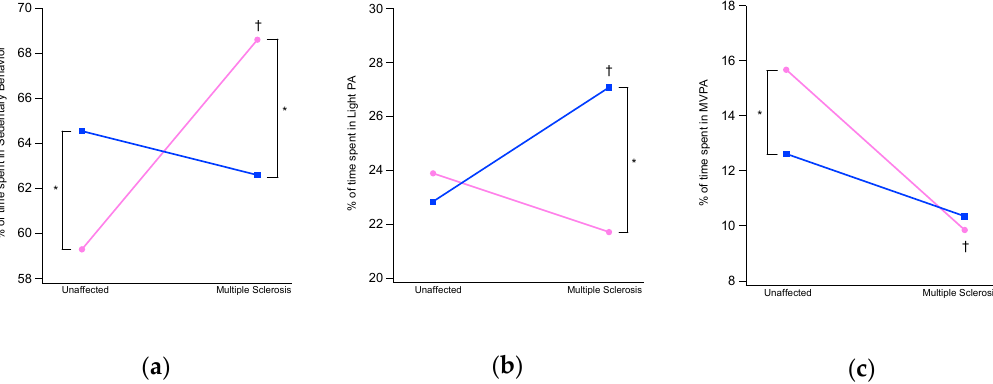
Figure 4. ( a ) percentages of time spent in Sedentary Behavior, ( b ) Light Intensity and ( c ) Moderate- to-vigorous intensity Physical Activity in women (pink lines) and men (blue lines) with Multiple Sclerosis and una ff ected individuals. The symbol † denotes a significant di ff erence between una ff ected individuals and people with MS after Bonferroni correction ( p < 0.016). The symbol * denotes a significant di ff erence between women and men after Bonferroni correction ( p < 0.016).